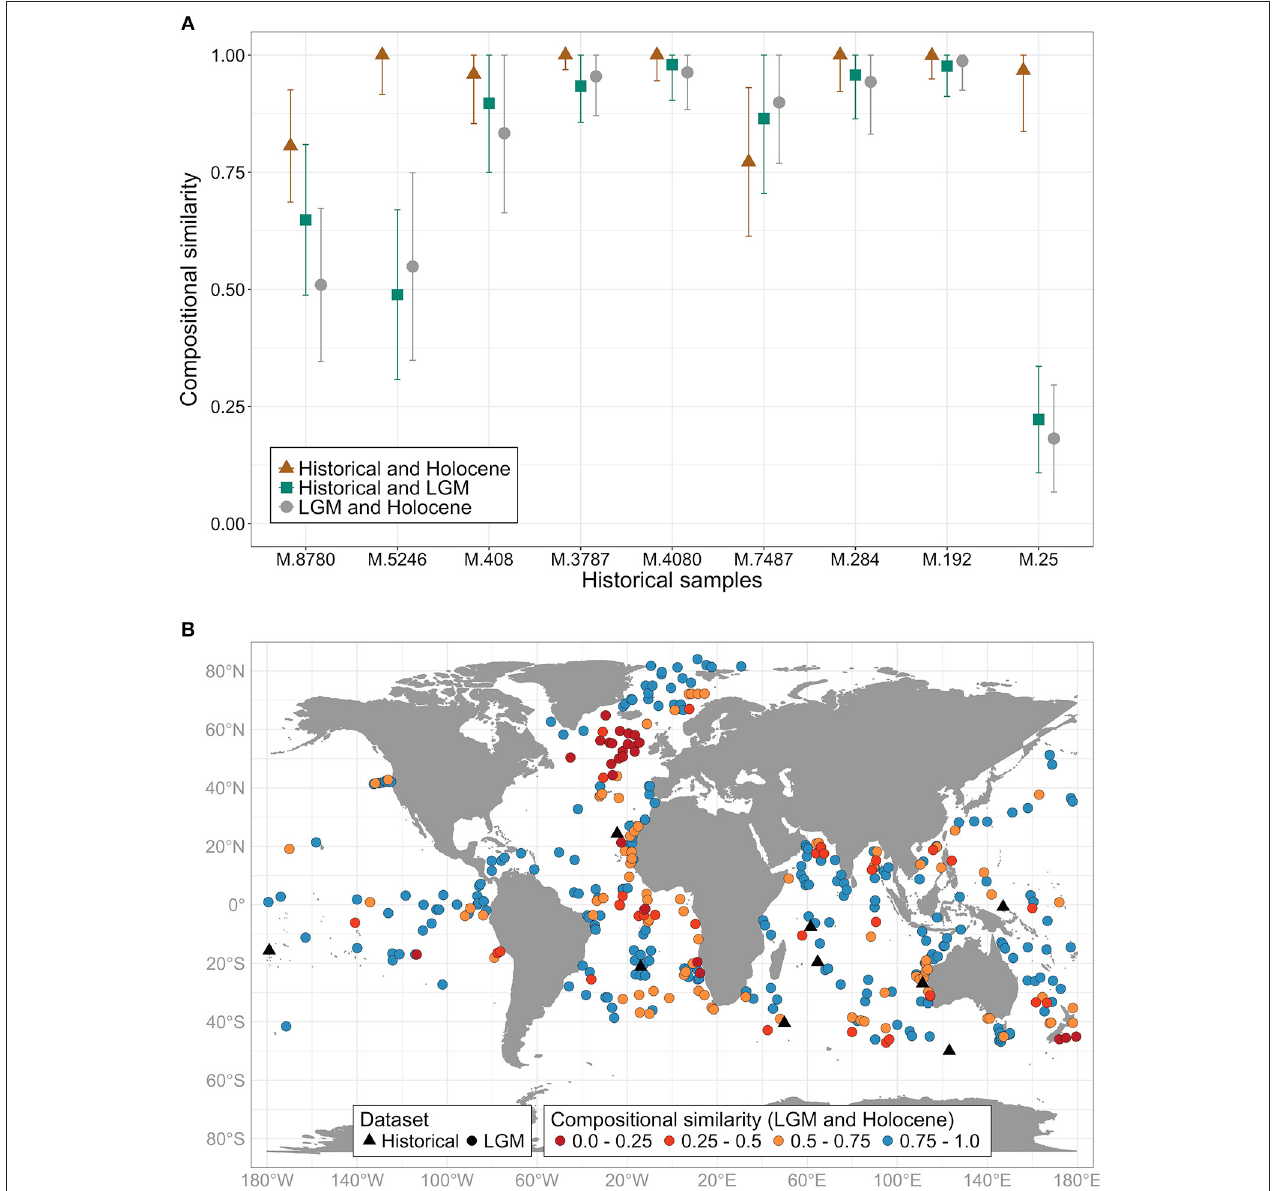
FIGURE 1 | (A) Compositional similarity (Morisita-Horn index) between planktonic foraminiferal assemblages from historical sediment samples and assemblages from surface sediments (Holocene, brown triangle) and from the Last Glacial Maximum (LGM, green squares); and between Holocene and LGM assemblages (gray dots, baseline value of local temporal turnover). 0 means that the two assemblages share no species; 1 means that the same species were present in both samples at statistically indistinguishable proportions. Lines represent confidence intervals based on 100 bootstrap replicates. The x-axis shows the historical sample number. (B) Black triangles: historical samples (nine in total). Colored dots: LGM samples from 389 sites worldwide. The colors represent the Morisita-Horn similarity index between the LGM sample and its neighboring Holocene sample (i.e., temporal turnover). Red to orange dots indicate low similarity (i.e., high species turnover), whereas blue dots indicate similar Holocene and LGM planktonic foraminifera